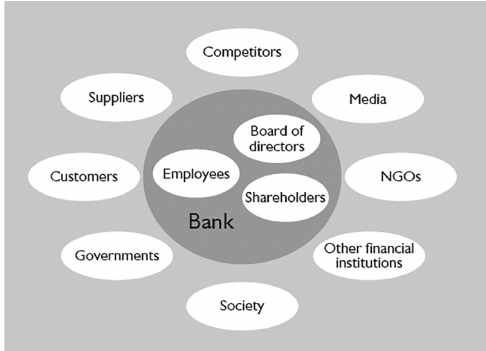
Figure 1. Sustainability strategy and (internal and external) stakeholders Source : Jeucken and Bouma